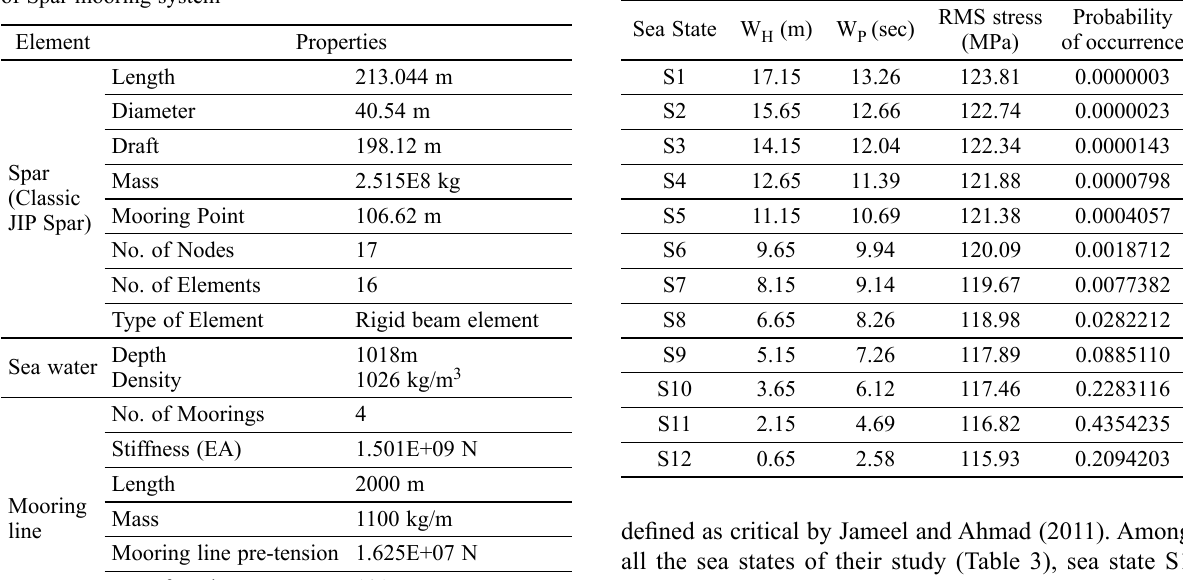
Table 3. Severe dynamic stresses (Jameel, Ahmad